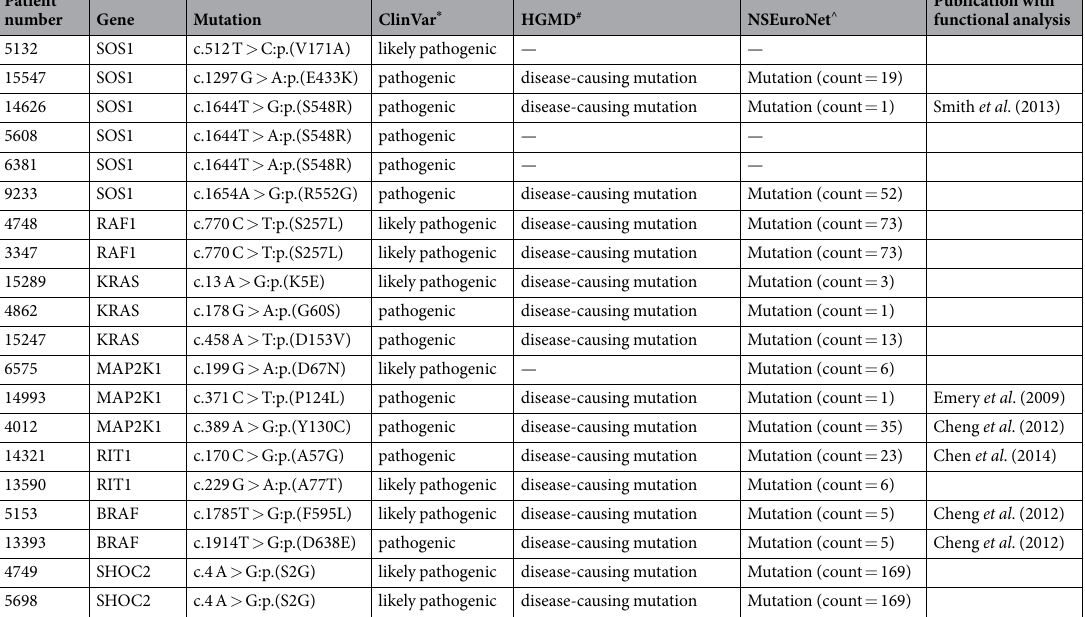
Table 1. A summary of 20 patients identified with pathogenic or likely pathogenic mutations from our cohort using the multigene panel sequencing approach. * Clinical significance was labelled according to the ClinVar database from NCBI (https://www.ncbi.nlm.nih.gov/clinvar/). # Variant class was determined according to the HGMD (Human Gene Mutation Database http://www.hgmd.cf.ac.uk/docs/new_help.html). ^